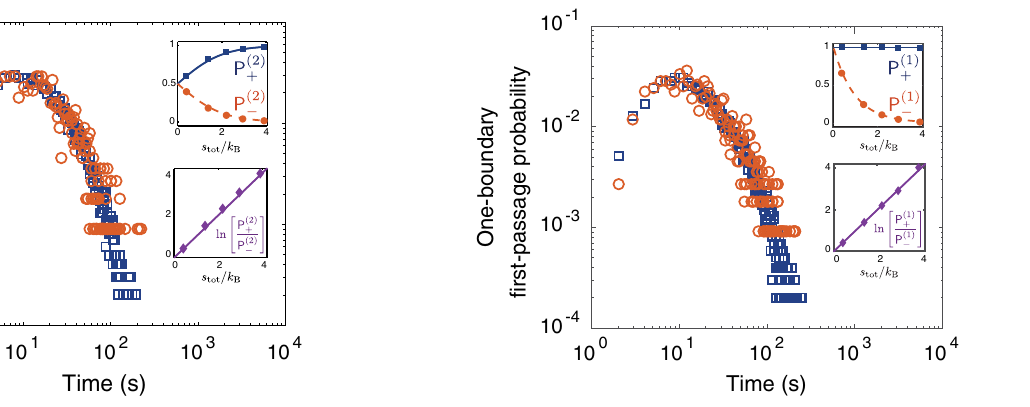
FIG. 7. Empirical two-boundary first-passage-time distribu- FIG. 8. Empirical one-boundary first-passage-time distribu- tions of entropy production to first reach a positive threshold tions of entropy production to first reach a positive threshold p p ð t ; s tot Þ (blue squares) and the rescaled distribution for the ð t ; s tot Þ (blue squares), and the rescaled distribution for the T ð 2 Þ T ð 1 Þ þ þ negative threshold p negative threshold p ð t ; − s tot Þ e s tot =k B (red circles) for the ð t ; − s tot Þ e s tot =k B (red circles), for the T ð 2 Þ − T ð 1 Þ − Smoluchowski-Feynman ratchet with the potential (79) in a Smoluchowski-Feynman ratchet with the potential (79) in a steady state. The estimate of p ð t ; s tot Þ [ p ð t ; − s tot Þ ] is steady state. The distributions are obtained from 10 4 numerical T ð 1 Þ T ð 1 Þ − 2 . 2 k þ simulations, and the threshold values are set to (cid:4) s . obtained by measuring the time when entropy production first tot ¼ (cid:4) B The simulations are done using the Euler numerical scheme with 2 . 2 k reaches the single absorbing boundary s tot ¼ B 300 K, the following parameters: F ¼ 0 . 64 pN, T − 2 . 2 k ( − s ) in 10 4 simulations. The simulations are done env ¼ tot ¼ B l ¼ 2 π nm, γ ¼ 8 . 4 pN s = nm, V k T , and simulation time 0 ¼ with the same parameters as in Fig. 7, and the empirical B env step Δ t ¼ 0 . 0127 s. Top inset: Empirical passage probabilities of probabilities are calculated over a total simulation time of 2 Þ τ 20 s. Top inset: Empirical passage probabilities of en- entropy production to first reach the positive threshold ( P ð , blue þ max ¼ 1 Þ squares) and to first reach the negative threshold ( P ð 2 Þ − , red circles) tropy production with a positive-threshold ( P ð , blue squares) þ as a function of the threshold value s . The analytical expres- and with a negative-threshold ( P ð 1 Þ − , red circles) as a function of tot 2 Þ sions for P ð (blue solid line), given by Eq. (47), and for P ð 2 Þ − (red the values of the thresholds. For comparison, the expression for þ dashed line), given by Eq. (48), are also shown. Bottom inset: P ð 1 Þ given by Eq. (53) (blue solid line) and the expression for P ð 1 Þ − þ Logarithm of the ratio between the empirical passage probabil- given by Eq. (54) (red dashed line) are also shown. Bottom inset: 2 Þ 1 Þ ities P ð and P ð 2 Þ − as a function of the threshold value s Logarithm of the ratio between P ð and P ð 1 Þ − as a function of the tot þ þ (magenta diamonds). The solid line is a straight line of slope 1. threshold value (magenta diamonds). The solid line is a straight line of slope